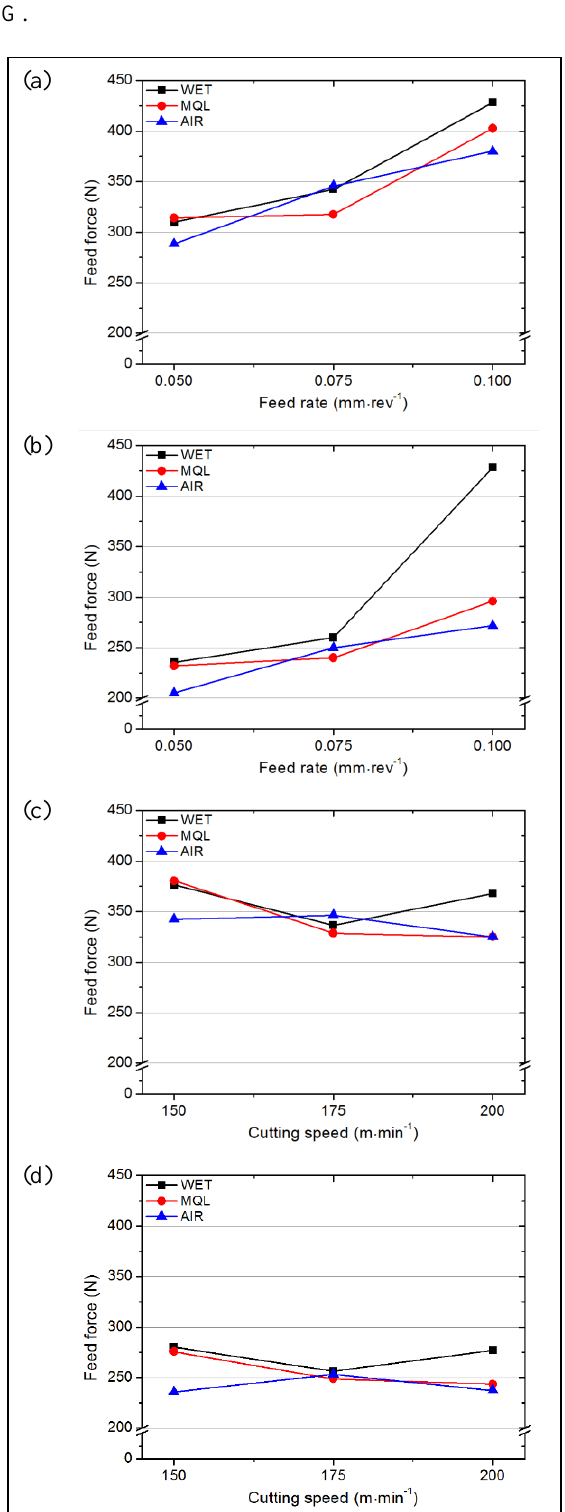
Figure 4: Average feed force ( F x ) as a function of: (a) feed rate for SG; (b) feed rate for PG; (c) cutting speed for SG; (d) cutting speed for